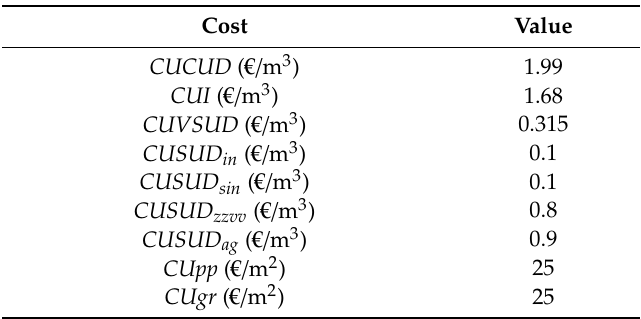
Figure 2. Catchments delineated in the metropolitan area of San Luis Potos í (numbers of axis represent UTM coordinates). Table 3. Land use areas (10 4 m 2 ) by catchment. Table 4. Unitary costs for the optimization problem.